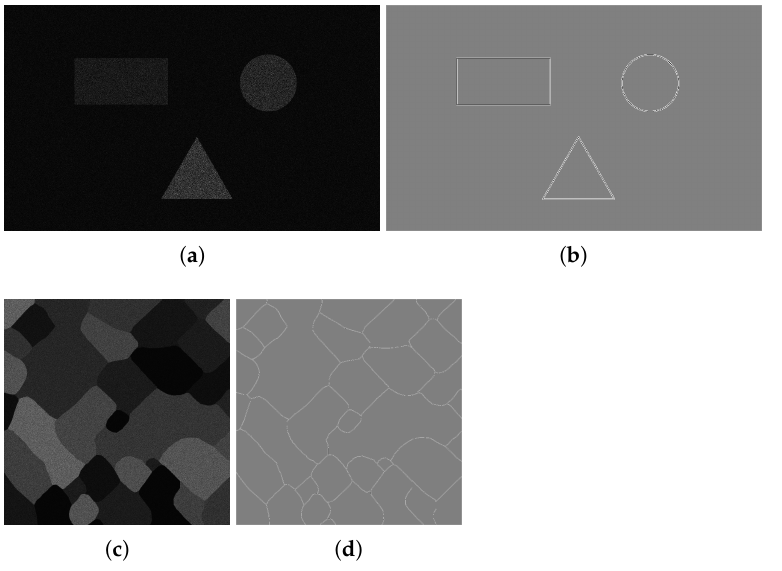
Figure 11. ( a , b ) The first simulated SAR image and its ground truth (GT) map; ( c , d ) the second simulated SAR image and its ground truth (GT)